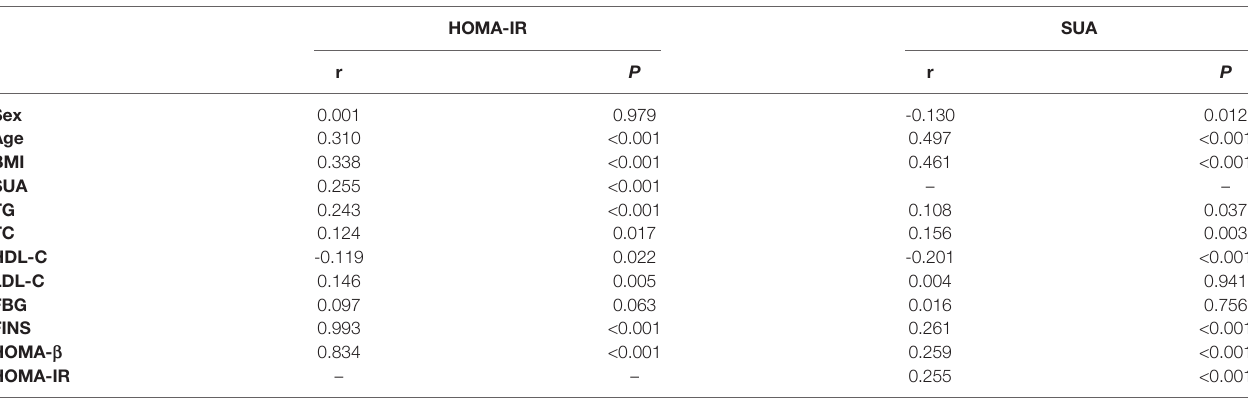
TABLE 2 | Univariate analysis examining the association of BMI and SUA with